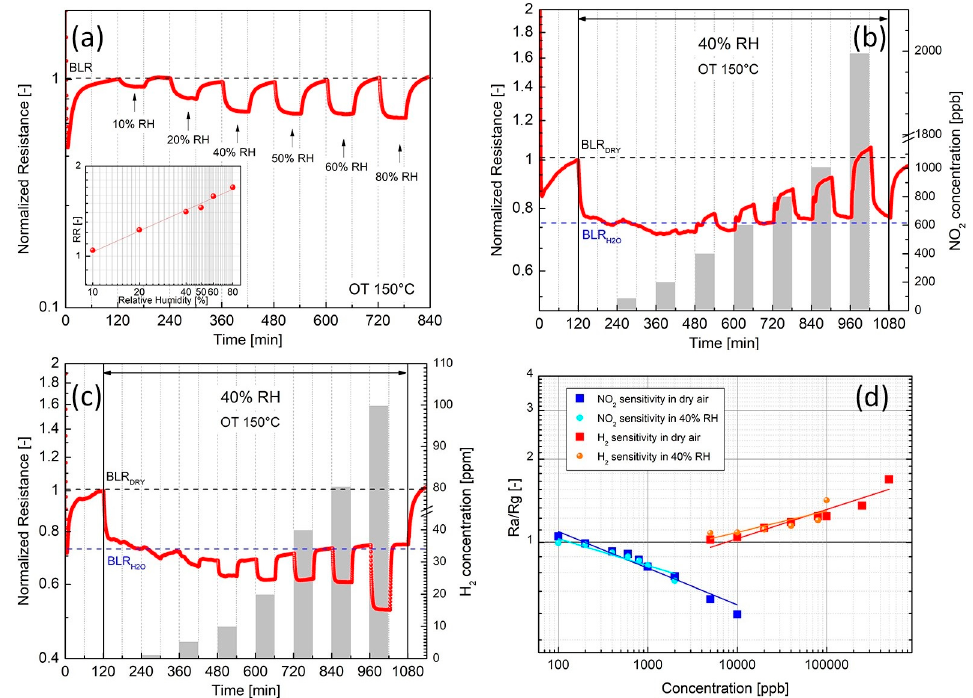
Figure 10. Electrical responses of the exfoliated WS 2 post-annealed at 180 ◦ C (150 ◦ C operating temperature) to di ff erent Relative Humidity (RH) conditions. ( a ) Normalized dynamic response to humidity (10–80% RH). The inset depicts the corresponding sensitivity plot. ( b ) Dynamic response to increasing NO 2 concentrations in air with 40% RH, ( c ) Dynamic response to increasing H 2 concentrations in air with 40% RH, ( d ) Comparison of the sensitivity plots to NO 2 and H 2 in dry air and 40% RH, respectively.